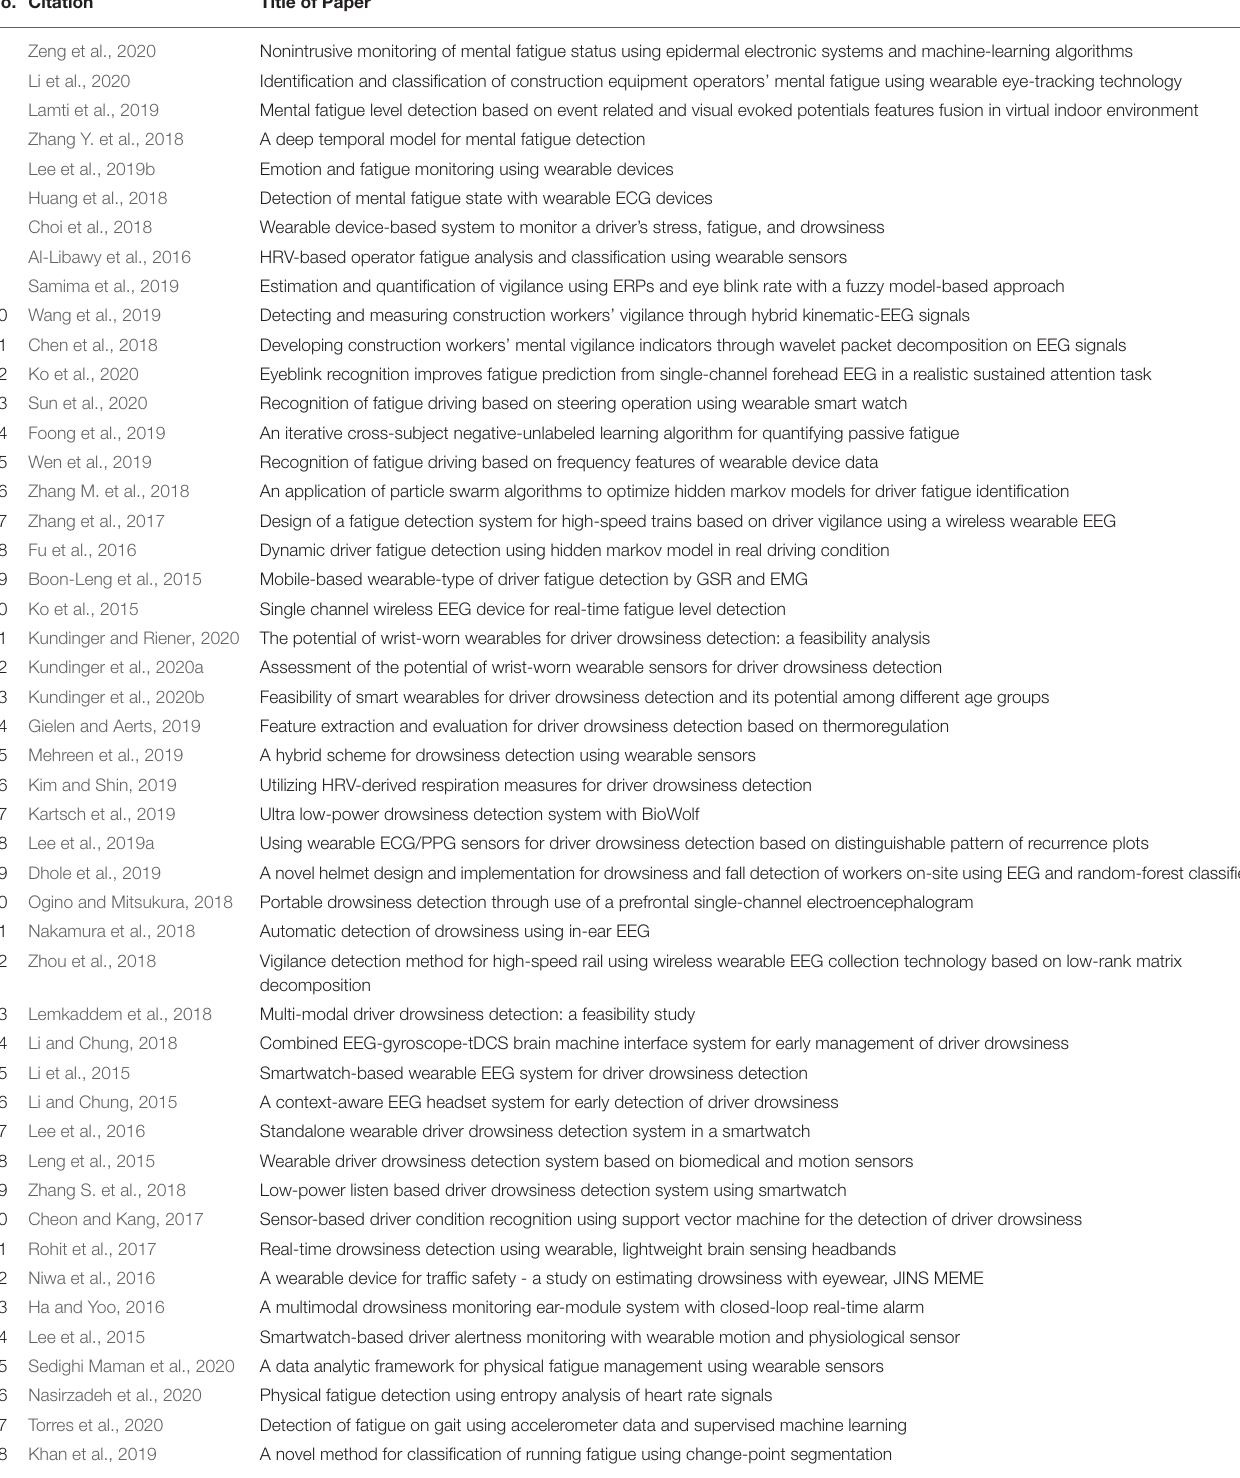
TABLE 1 | List of included studies with the respective number and citation information, starting from studies addressing mental fatigue (#1–#8), followed by studies addressing vigilance detection (#9–#11), drowsiness (#12–#44), physical fatigue (#45–#56) and, lastly, muscle fatigue